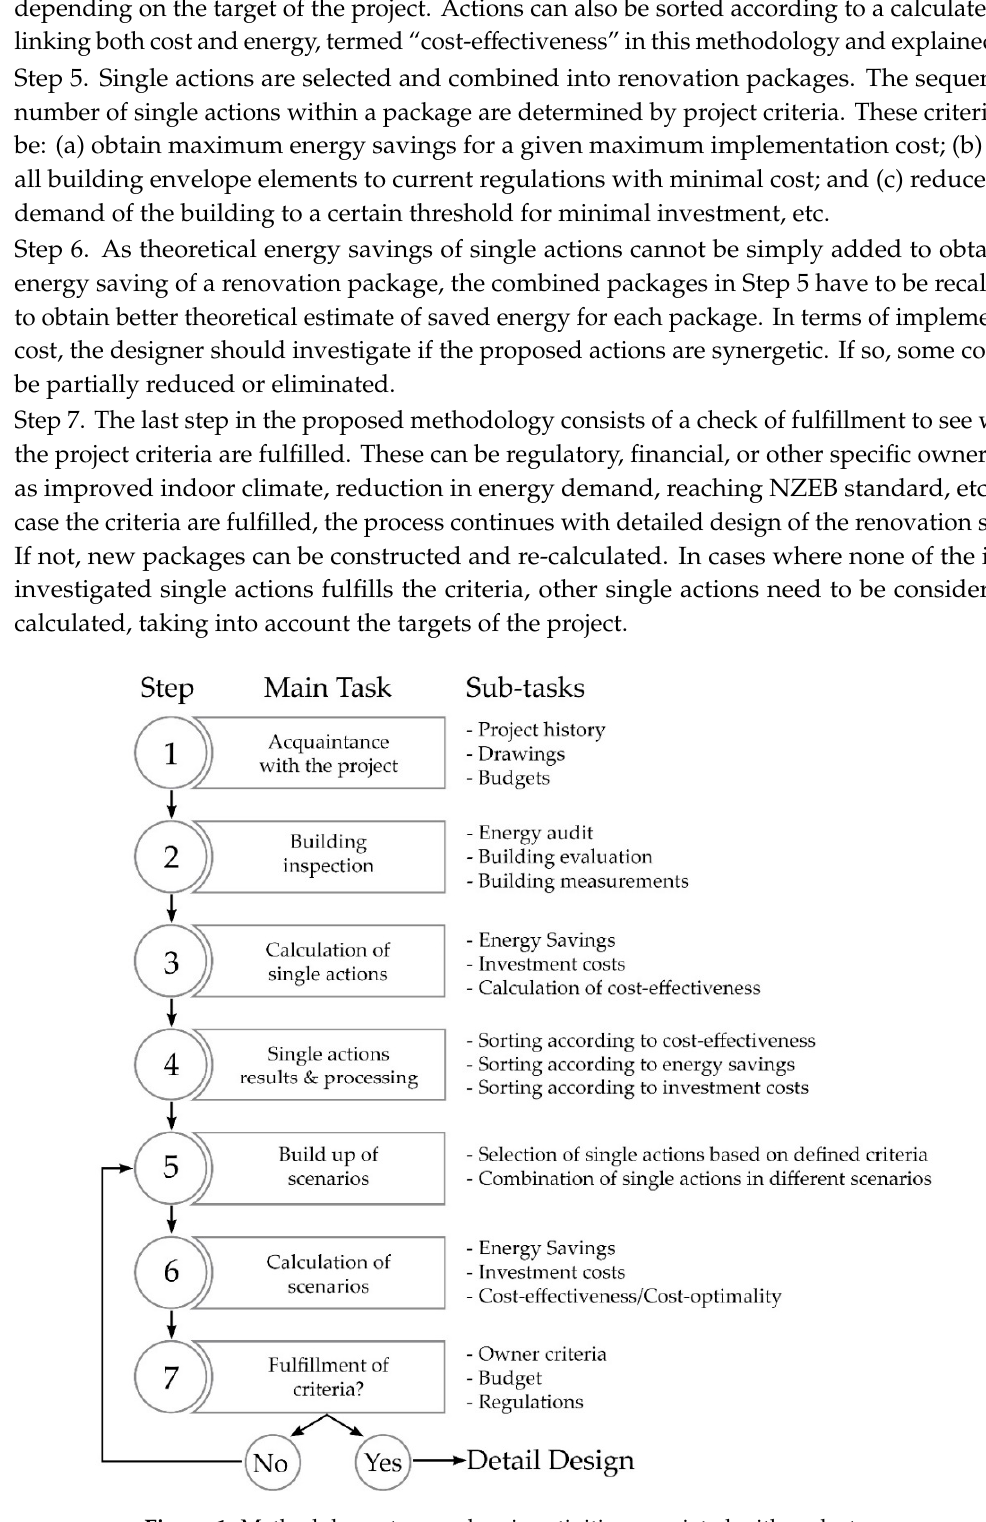
Figure 1. Methodology steps and main activities associated with each step.